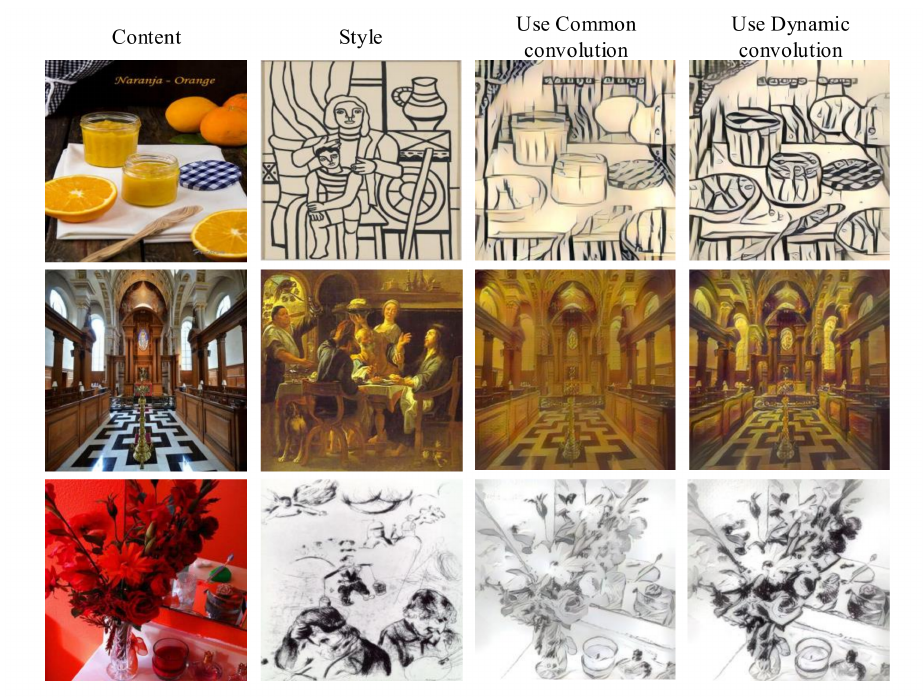
Figure 9. Dynamic convolution ablation